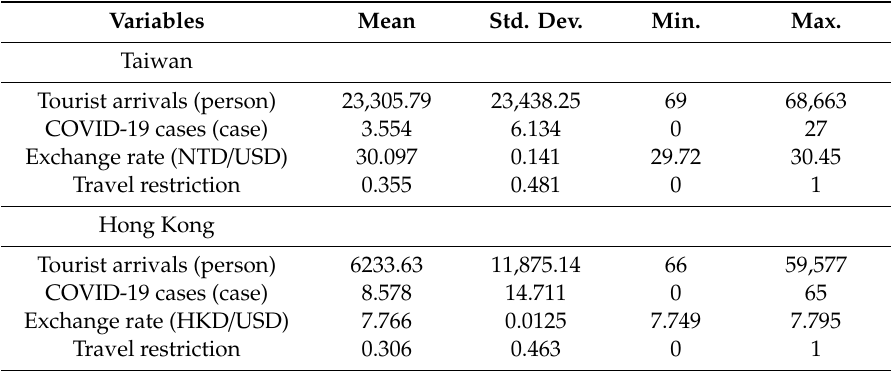
Table 2. Descriptive statistics of